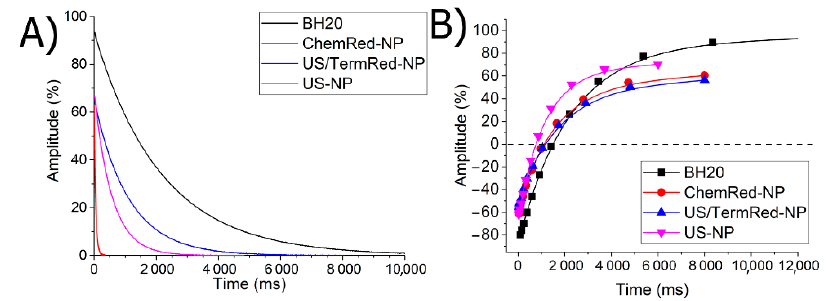
Figure 8. ( A ) Transverse dependence of relaxation on time; ( B ) longitudinal dependence of relaxa-